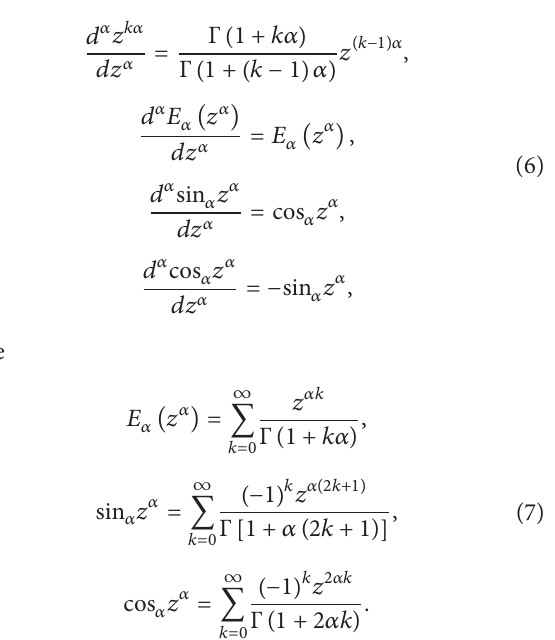
fractional 𝑍 -transform method are presented. In Section 4, some examples and applications of this method are